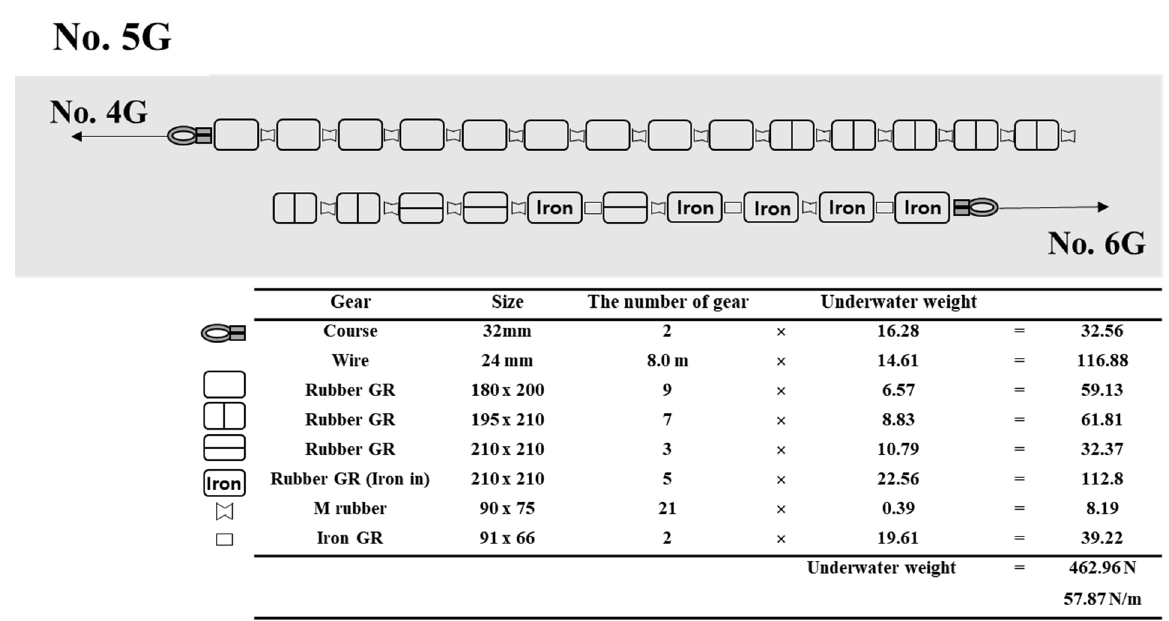
Figure 12. The arrangement of ground gear in conventional designed ground rope.